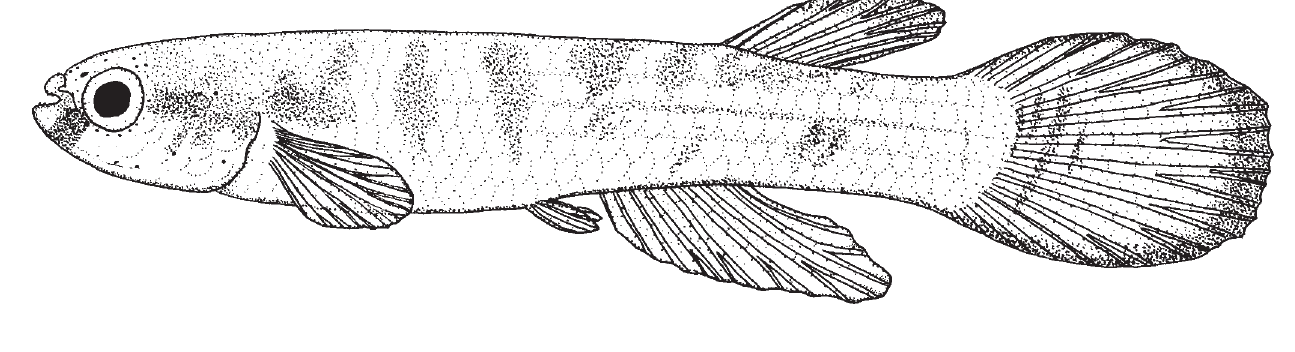
Fig. 1. Rivulus kirovskyi , holotype, UFRJ 5935, male, 20.3 mm SL; Brazil: Amazonas: